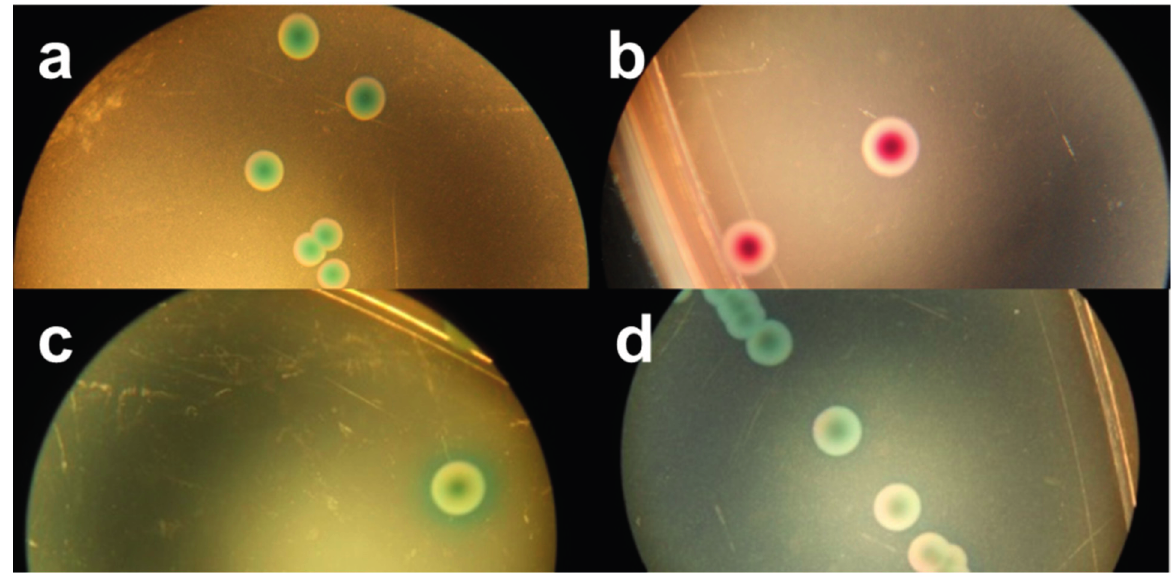
Figure 3. Stereo-microscopic view ( a – d ) of modified MacConkey agar as described by Possé et al. [14], inoculated with STEC strains. (( a ) STEC O145 (MB 5850), ( b ) STEC O26 (MB 5316), ( c ) STEC O103 (MB 5307) and ( d ) STEC O111 (MB